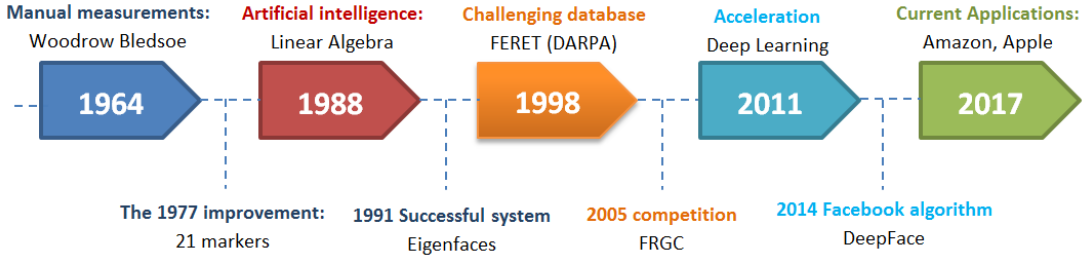
Figure 1. Primary stages in the history of face recognition.